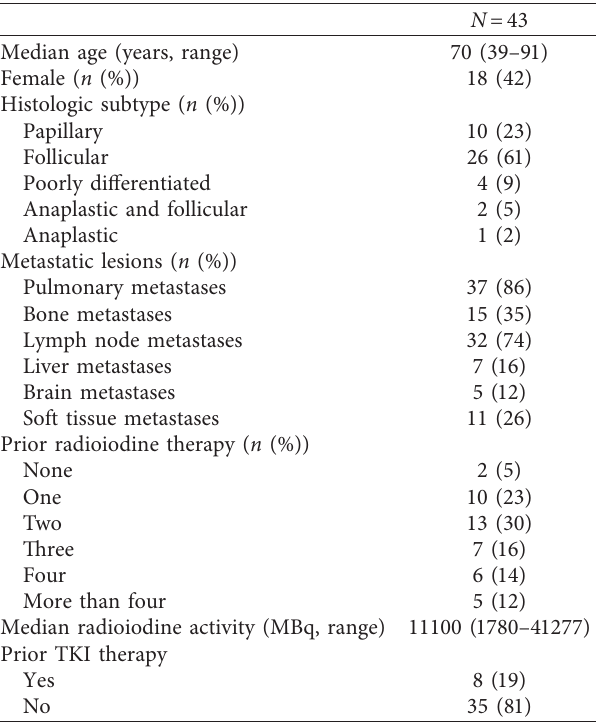
Table 1: Patient